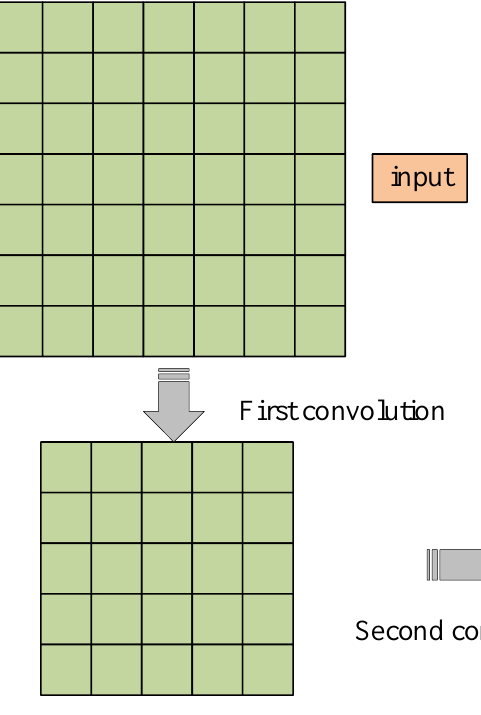
Figure 5. Receptive field.